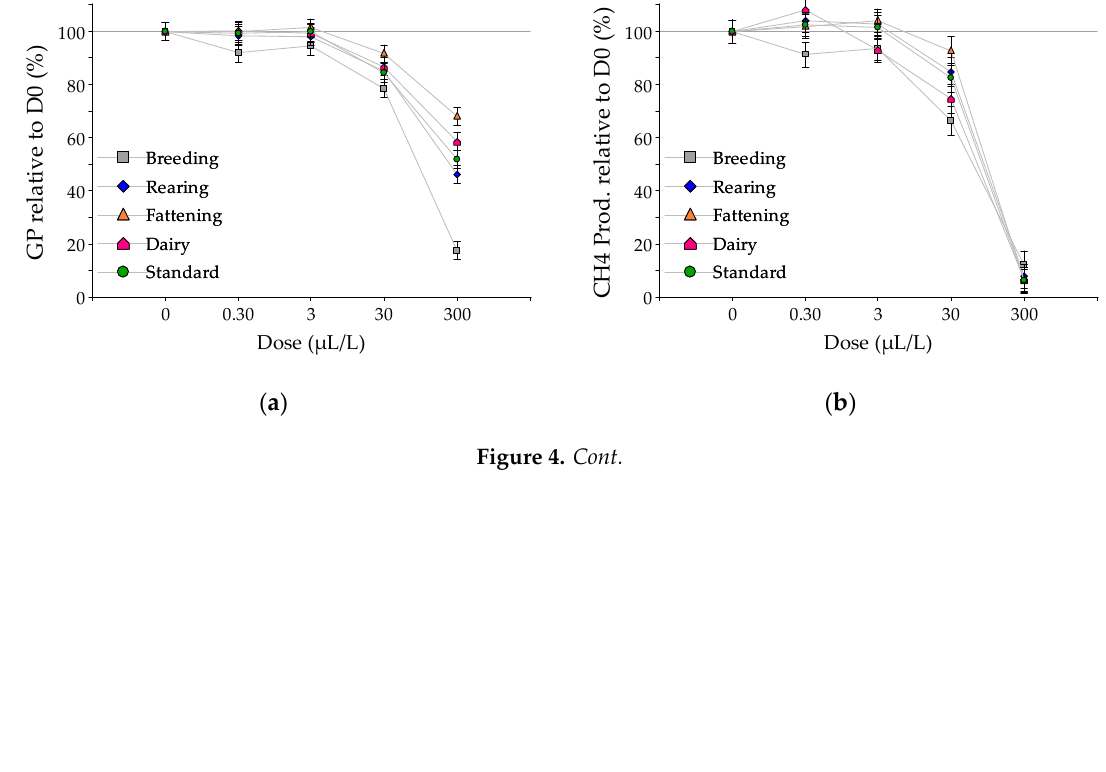
Figure 4. Relative responses compared to control (dose 0 = 100%) for ( a ) total gas production; ( b ) methane production; ( c ) organic matter digestibility (OMD) and ( d ) neutral detergent fiber digestibility (NDFD), to increasing doses of Tagetes minuta essential oil in the in vitro fermentation of